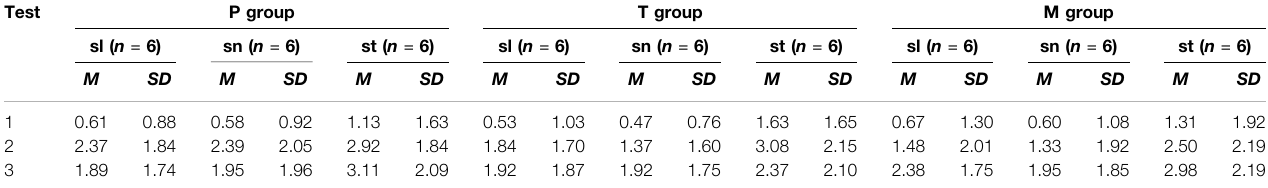
TABLE 3 | Descriptive statistics for sC production over time, across three experimental groups (Mean scores) in Listen and Repeat test. Test P group T group